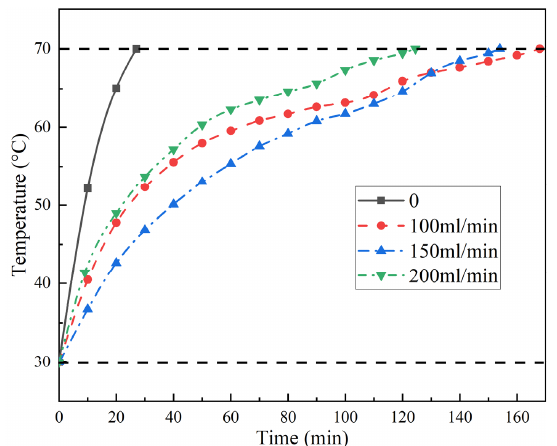
Figure 10. Comparison of thermal − protection performances with different flowrates.